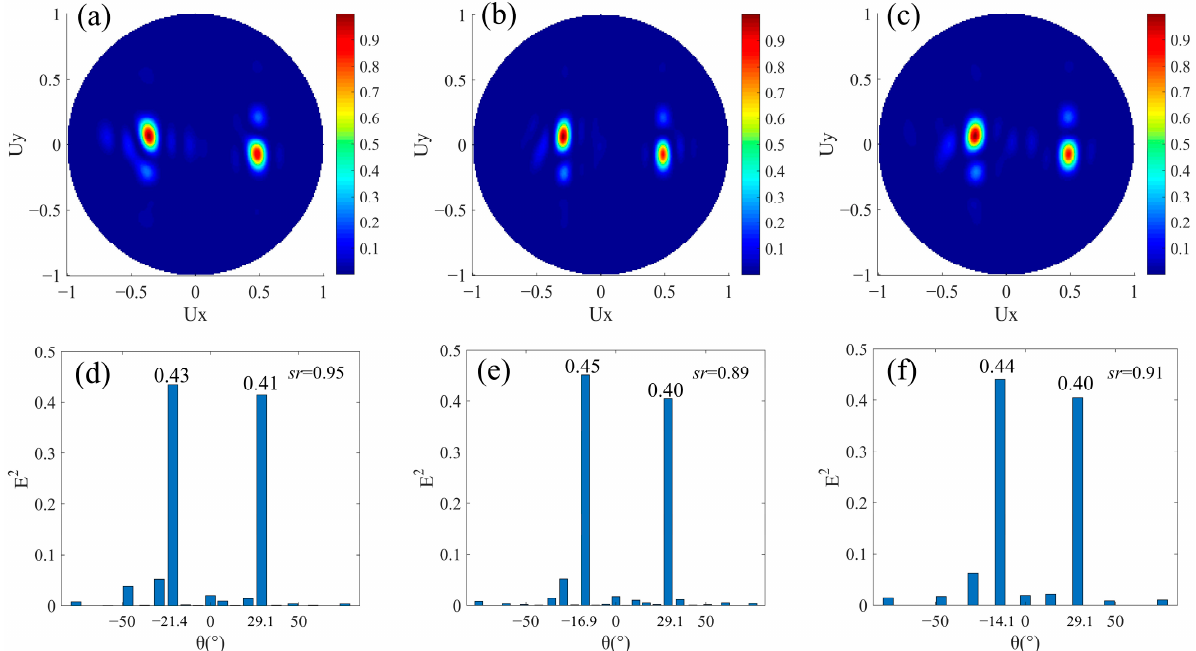
Figure 3. Simulation results of beam splitters with different split angles and same split energy. N l ≠ N r , M = 0. The normalized far-field projection intensity distributions of designs ( a ) N l = 4, N r = 3, ( b ) N l = 5, N r = 3, and ( c ) N l = 6, N r = 3, respectively. ( d – f ) are the normalized field intensity under the main split angle corresponding to the results of ( a – c ), respectively.